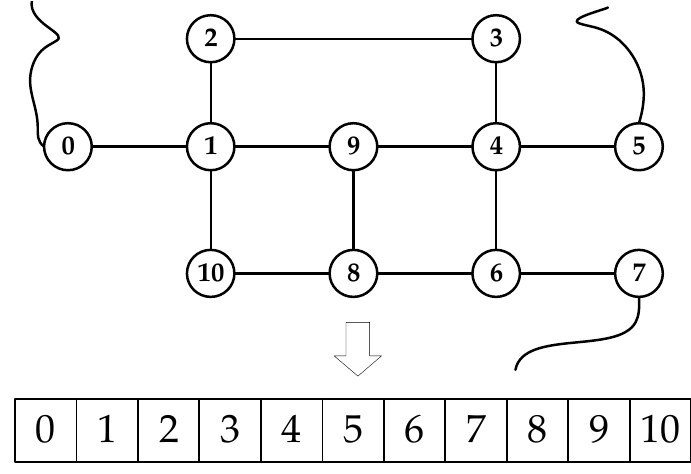
Figure 6. Mapping from a local subgroup of the road network to chromosome.